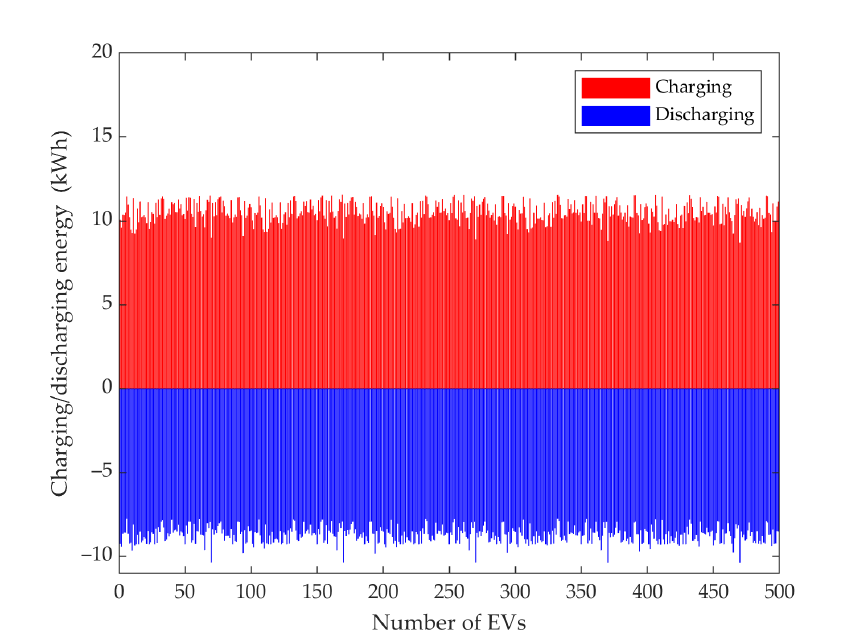
Figure 13. Individual EV charging and discharging energy from t 1 on the first day to t 1 on the second day in Scenario #5.